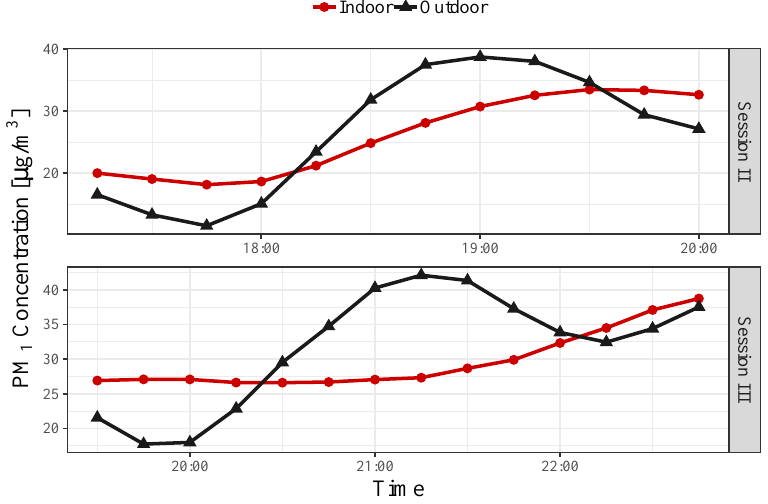
Figure 5. Indoor and outdoor PM 1 mass concentration time series.